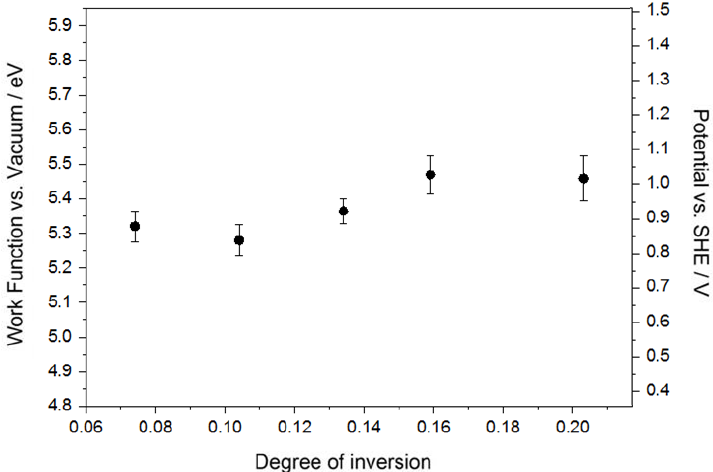
Figure 3. Work function of the ZFO pellet samples with degrees of inversion ranging from x ≈ 0.07 to x ≈ 0.20. The values were measured using a scanning Kelvin probe system. Before the measurement, the pellets were calcined at 673 K for 12 h to remove adsorbed water.